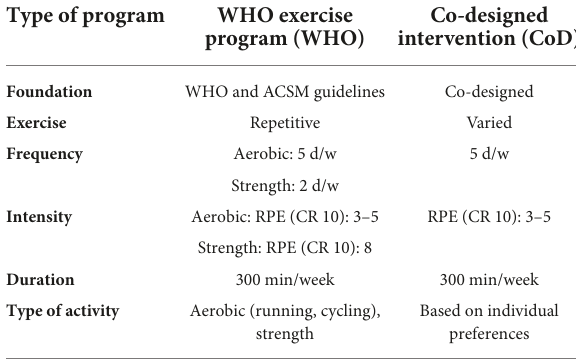
TABLE 1 Comparison of the characteristics of the exercise program based on WHO recommendations and the co-designed